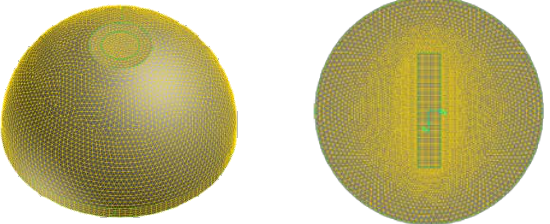
Figure 8. The appearance of the single-layer spherical recycling hood model after meshing is com- pleted.